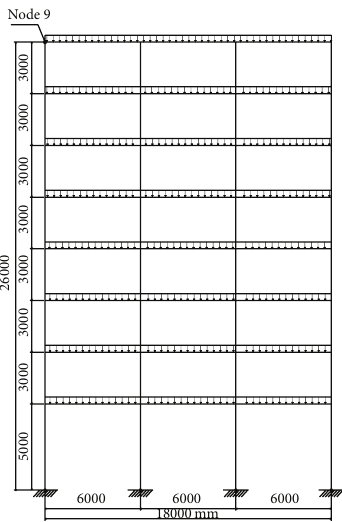
at end regions of the beam according to FEA are not extended at this time. Damage intensities at end regions of the column are also extended and damage regions are propagated to middle region from upper region of the column; after this time, damage zones are extended but propagation of damages are not seen according to both approaches at the 𝑡 = 1.8